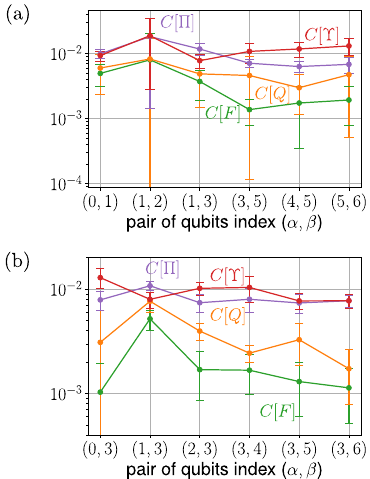
Fig. 4 Correlations in the joint measurement of pairs of qubits obtained by QND-MT. a Correlations in fi delity C [ F ], QNDness C [ Q ], and Choi operators C [ ϒ ] for the joint readout of each pair of physically connected qubits. b Same correlations C [ F ], C [ Q ], and C [ ϒ ] for the readout of qubit α = 3 with every other qubit of the